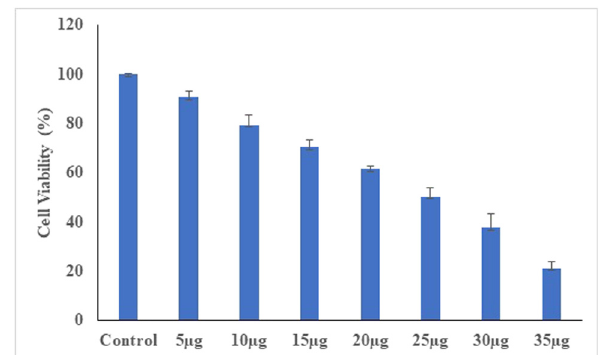
Figure 6: A dose dependent decrease in cell viability of HCT - 116 cell lines treated with CuO